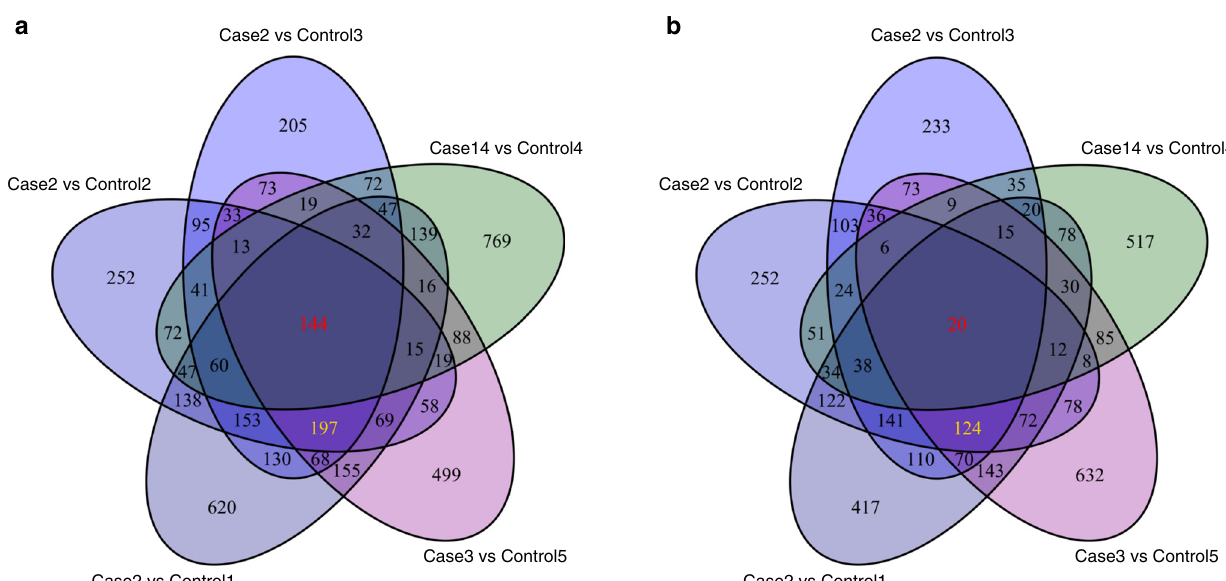
Fig. 6 Global transcriptome alteration in primary fi broblasts of AGO2 patients. a , b Venn diagram of upregulated ( a ) and downregulated ( b ) transcripts in fi broblasts isolated from AGO2 patients (cases 2, 3, and 14) compared to fi ve age-matched controls. The number of the upregulated ( a ) or downregulated ( b ) genes in all three cases are marked red, whereas deregulated genes in both cases bearing the p.L192P mutation are marked